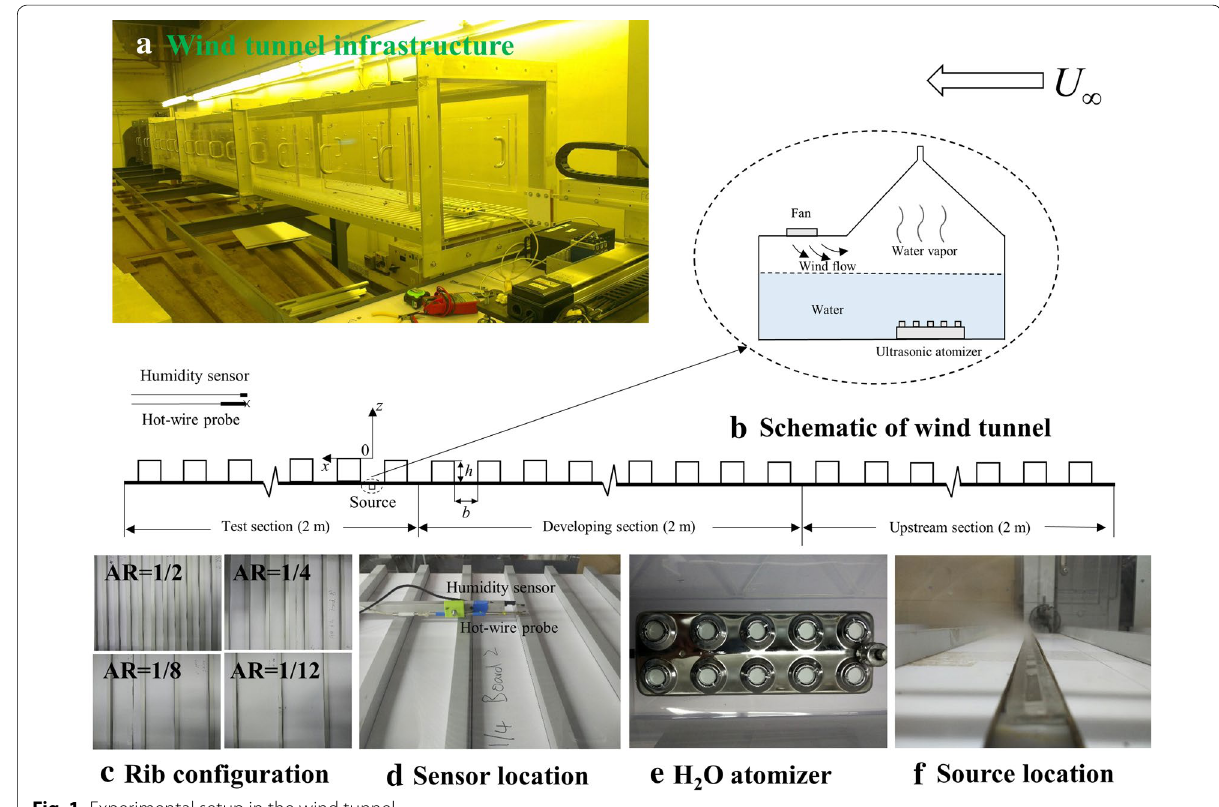
Fig. 1 Experimental setup in the wind